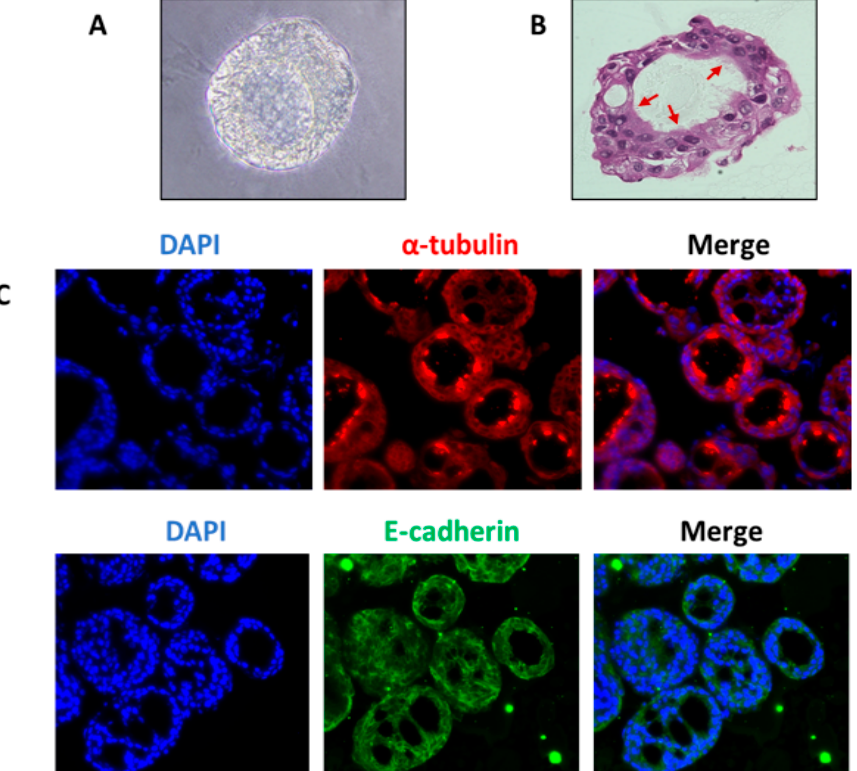
Figure 3. Organoid derived from human tracheobronchial epithelial cells (HTBEC): HTBECs were seeded on Matrigel and cultured in PneumaCult™ airway organoid seeding medium. Each dome consisted of 5000 cells with 90% Matrigel ® and 10% PneumaCult™ airway organoid seeding medium. After 7 days of expansion, cells were maintained in PneumaCult™ airway organoid differentiation medium for 21 days. After 21 days, organoids were processed for ( A ) Phase contrast microscopy ( B ) H&E staining (Red Arrows: Cilia) ( C ) Immunofluorescence staining showing tight junction of epithelial cells. (Red: α tubulin, Green: